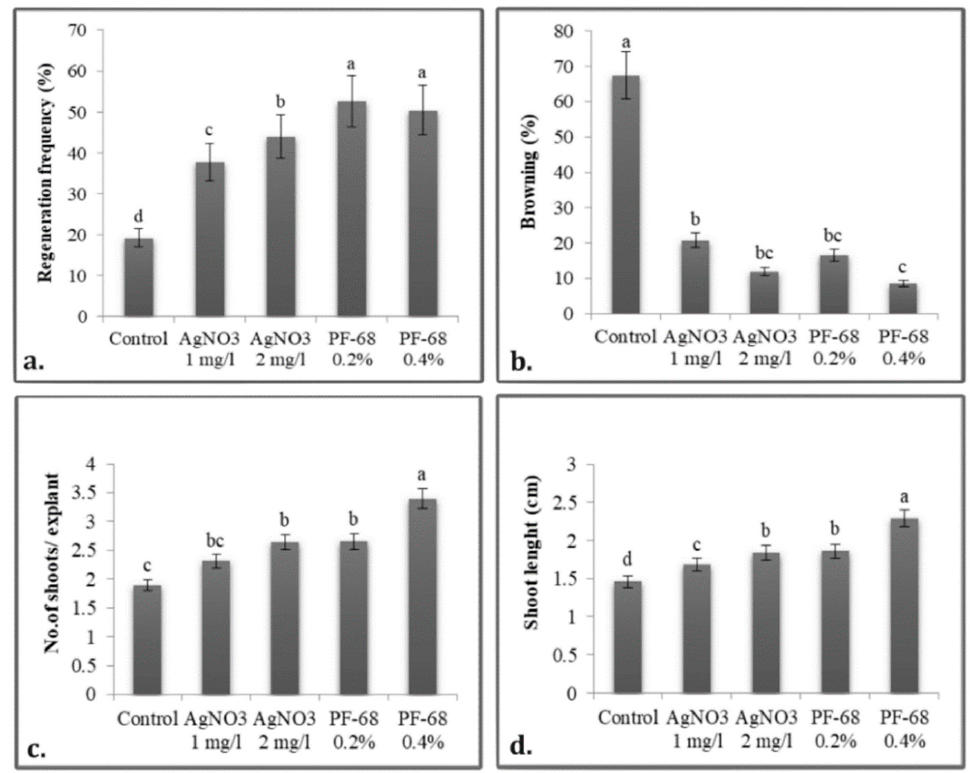
Figure 4. Unilateral influence of phenolic inhibitors on: ( a ) Regenerative frequency; ( b ) Necrosis rate; ( c ) Number of shoots per explant, ( d ) Shoot length in P. quadrangularis . The values shown are means ± SE (n = 3). Differences among treatments indicated by different letters are significant according to Duncan’s MRT test ( p < 0.05).